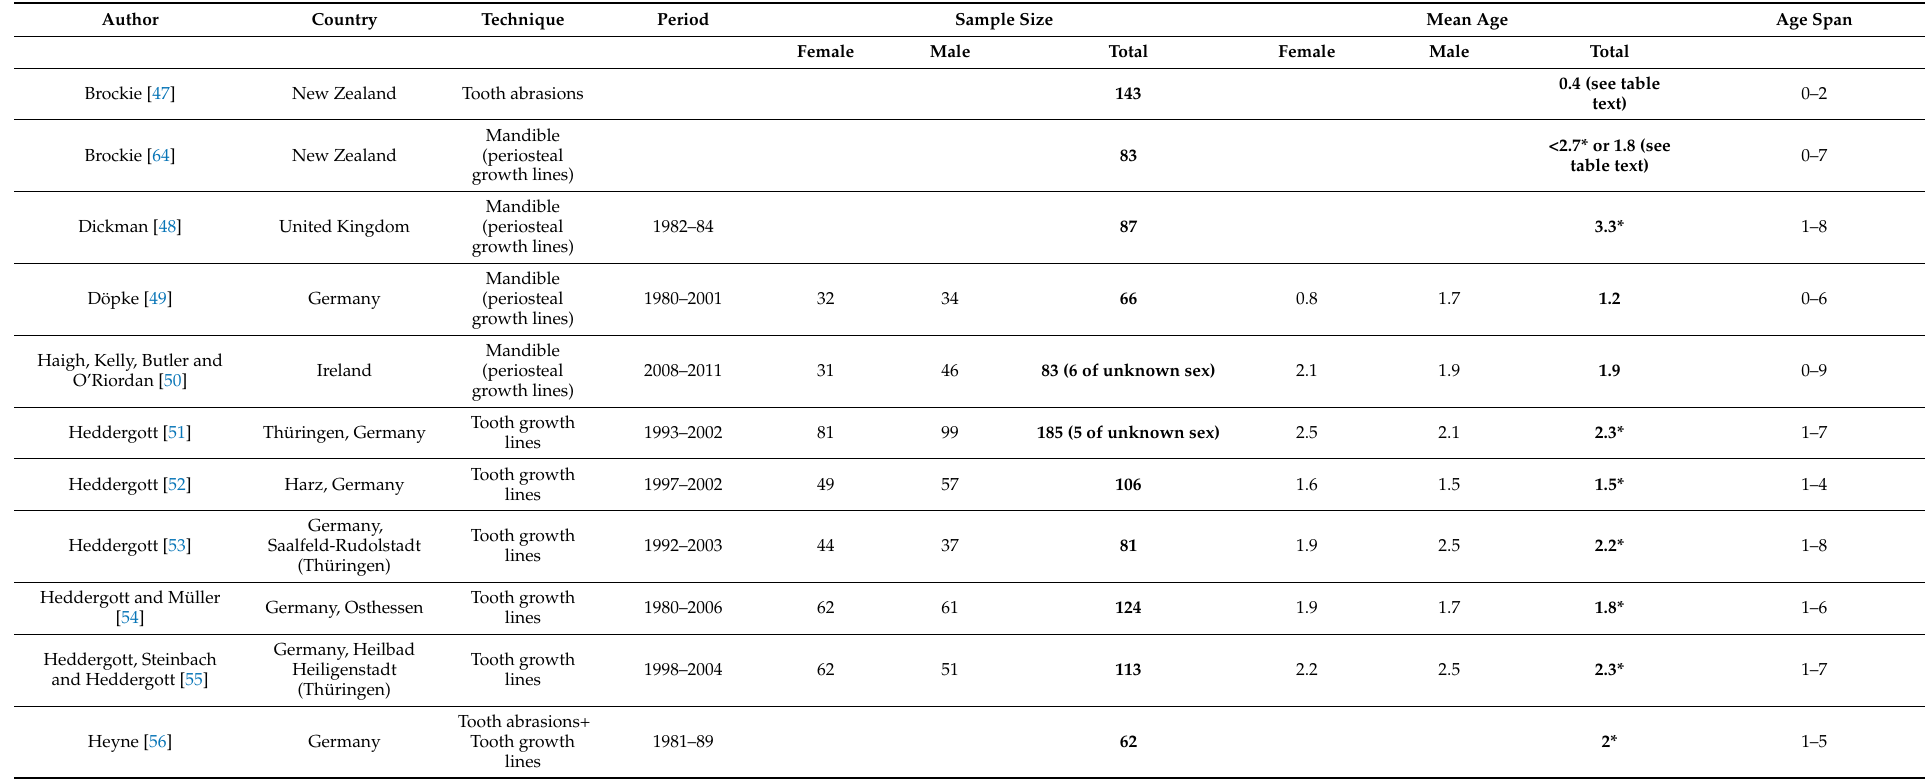
Table 1. Overview of age determination studies on hedgehogs, including the present study. * signifies that individuals of the age group 0–1 year have been omitted from the calculation of mean age. A blank field indicates missing data. Measures of age are presented in years. Brockie [47]: Detailed information was limited. One hundred forty-three individuals, 11% (n = 16) over 18 months (counted as 1-year-olds) and 7 over 2.5 years counted as 2-year-olds. The mean value is based on